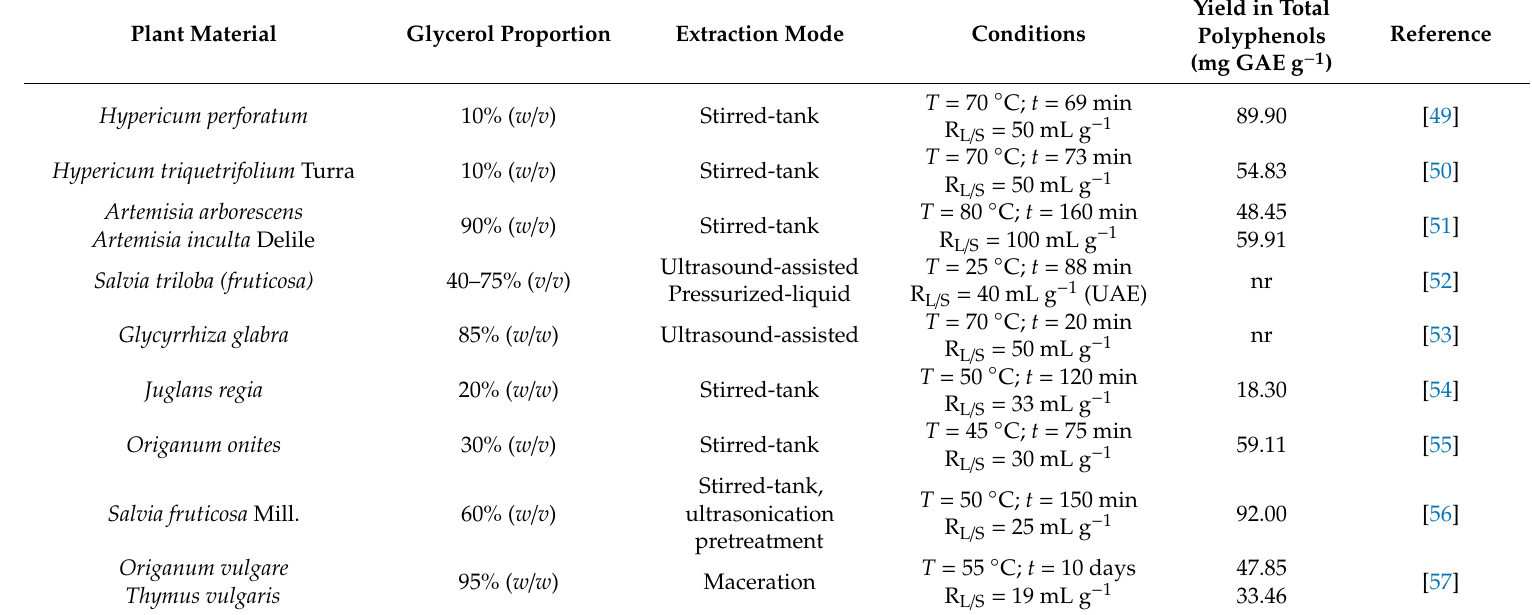
Table 2. Representative examples of total polyphenol recovery from botanicals using aqueous glycerol